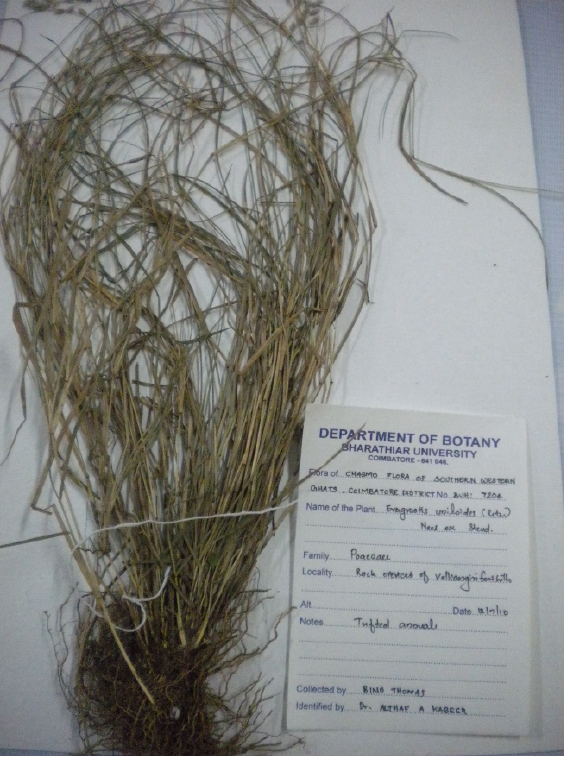
Image 20. Eragrostis uniloides (Retz.) Nees ex Steud.